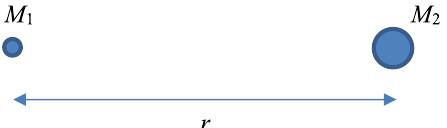
FIG. 1. Two asteroids, of mass M 1 and M 2 , separated by distance r . Andy asked students to “ guess ” the equation for the attractive gravitational force acting between the